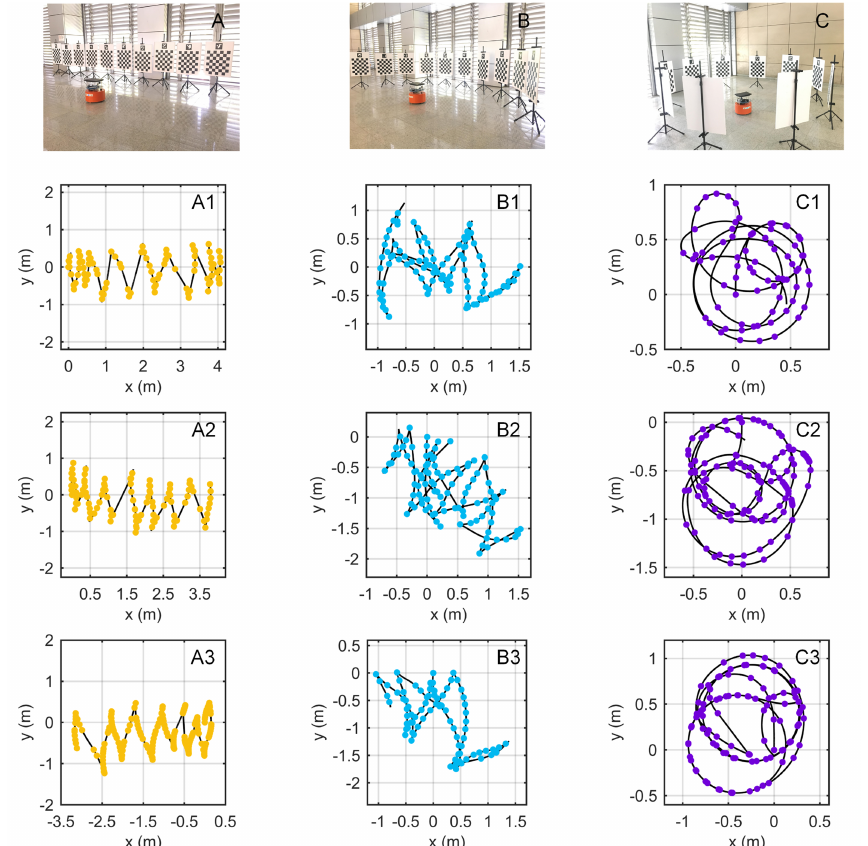
Figure 6. Experimental setup for the performance test. Ten targets were arranged in three forms: A, B, and C. Three data were recorded for each placement: data A1, A2, and A3 for form A, data B1, B2, and B3 for form B, and data C1, C2, and C3 for form C. Dots indicate selected keyframes, and lines indicate robot